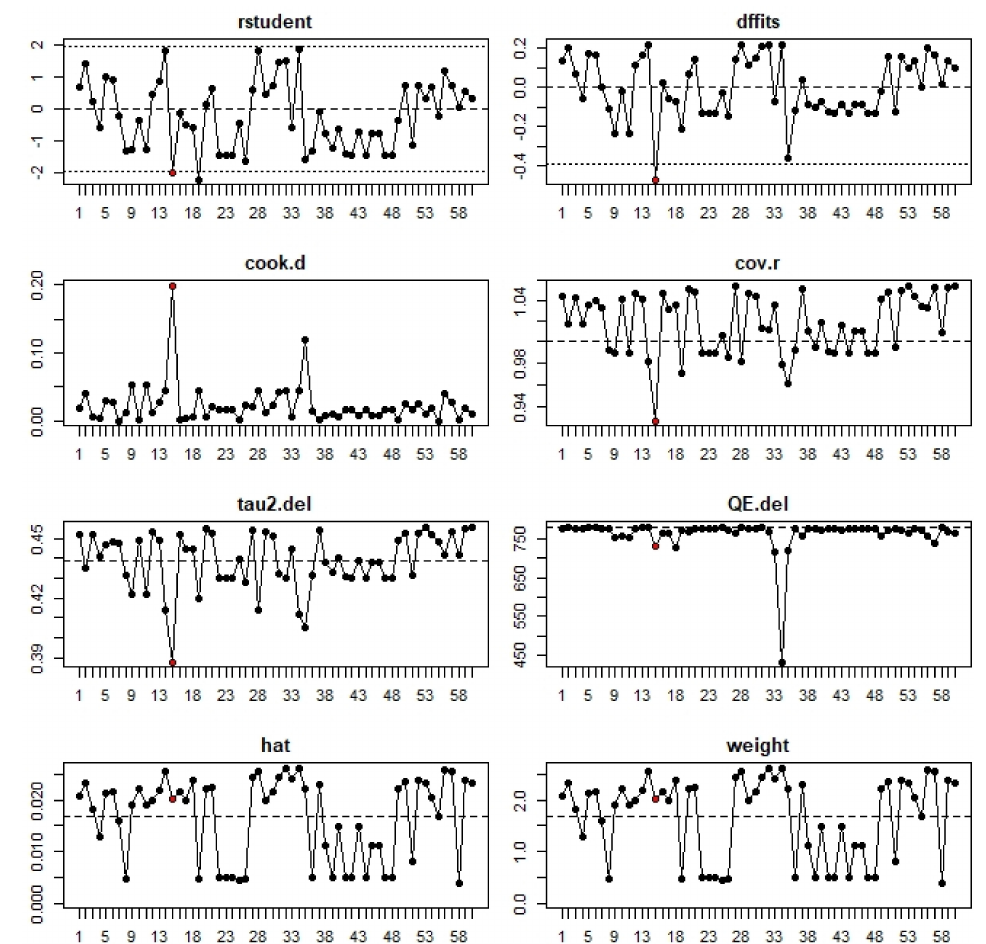
Figure A2. Influence analysis identifies study number 5 [90] as potential